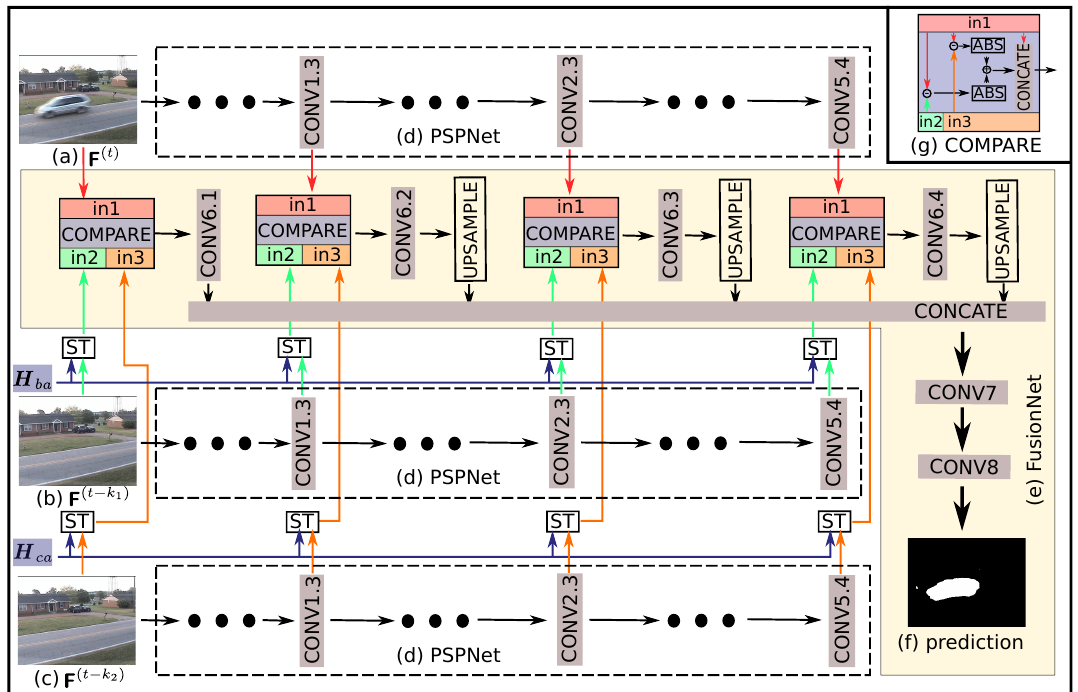
Figure 3. The architecture of our proposed STDFFnet. Firstly, features from chosen layers of PSPNet ( d ) are extracted, given inputs, including a current frame ( a ), previous frames ( b ), and ( c ), respectively. After that, the spatial transformations (ST) that are based on matrices H ba and H ca are conducted for the features from corresponding chosen layers. The spatial transformed feature maps, instead of the raw feature maps as used in DFFnet, are used as the inputs of the FusionNet ( e ). Finally, based on the features from ( a ) and the transformed features from ( b ) and ( c ), the FusionNet generates the foreground mask ( f ). The architecture of the comparing operator (COMPARE) is shown in the upper-right